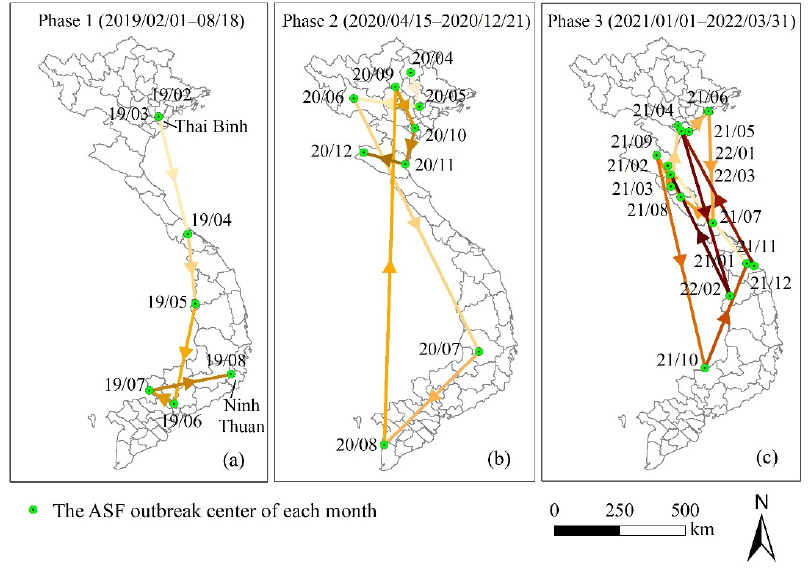
Table 3. Global Moran’s I of the ASF occurrence rate in Vietnam (February 2019–March 2022). Phase